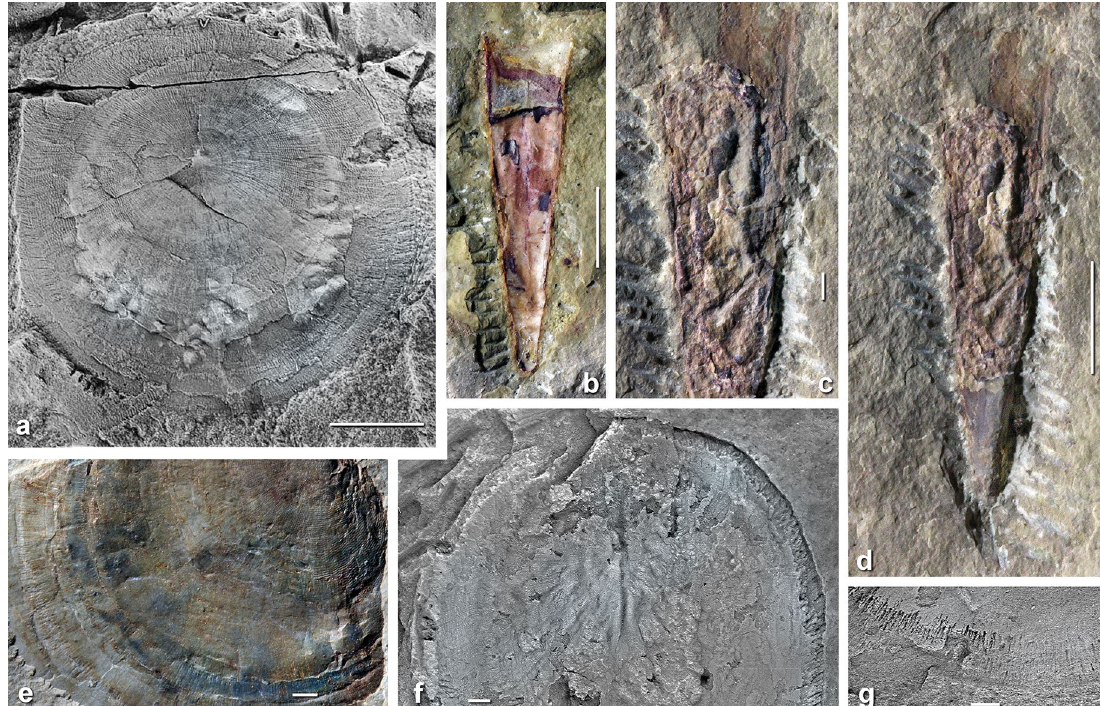
Figure 4. Examples of exceptional preservation in the upper Amouslek Formation, Daguinaspis Zone, western Anti-Atlas, Morocco, specimens from the Amouslek ( a , f , g ), Tazemmourt ( e ) and Tiout ( b – d ) sections. ( a , e – g ), Microschedia amphitrite Geyer 29 , mickwitziid brachiopod; ( a ) IGR 19998, visceral mass (presumably mostly parts the lophophore apparatus) pressed through the shell (visible as bulbous structures) and multiple, partly weakly mineralized shell layers (note punctate layer in the right half); ( e ) CGB 19c, partial valve with shell layers differently preserved and indeterminate internal organs indicated by concentric dark staining; ( f , h ) IGR 19988, slightly compressed shell with wrinkled surface partly exposing lower shell layers with granular tissue and partly dissolved edges with radially arranged crystallites; ( g ) IGR 19997, detail of shell showing partly edges with subradially arranged crystallites that indicate the arrangement of setae. ( b – d ), Nevadotheca ? sp., hyolith; ( b ) MMUW 2019E-002, incomplete conch in “normal” preservation with shell secondarily limonitized, largely removed exposing calcitic infilling, but with external ornament (fine comarginal striation) engraved to the internal mould; ( c , d ) MMUW 2019E-003, incomplete, secondarily limonitized conch with apertural two-thirds largely broken; split middle part exposes poorly preserved parts of selectively mineralized soft